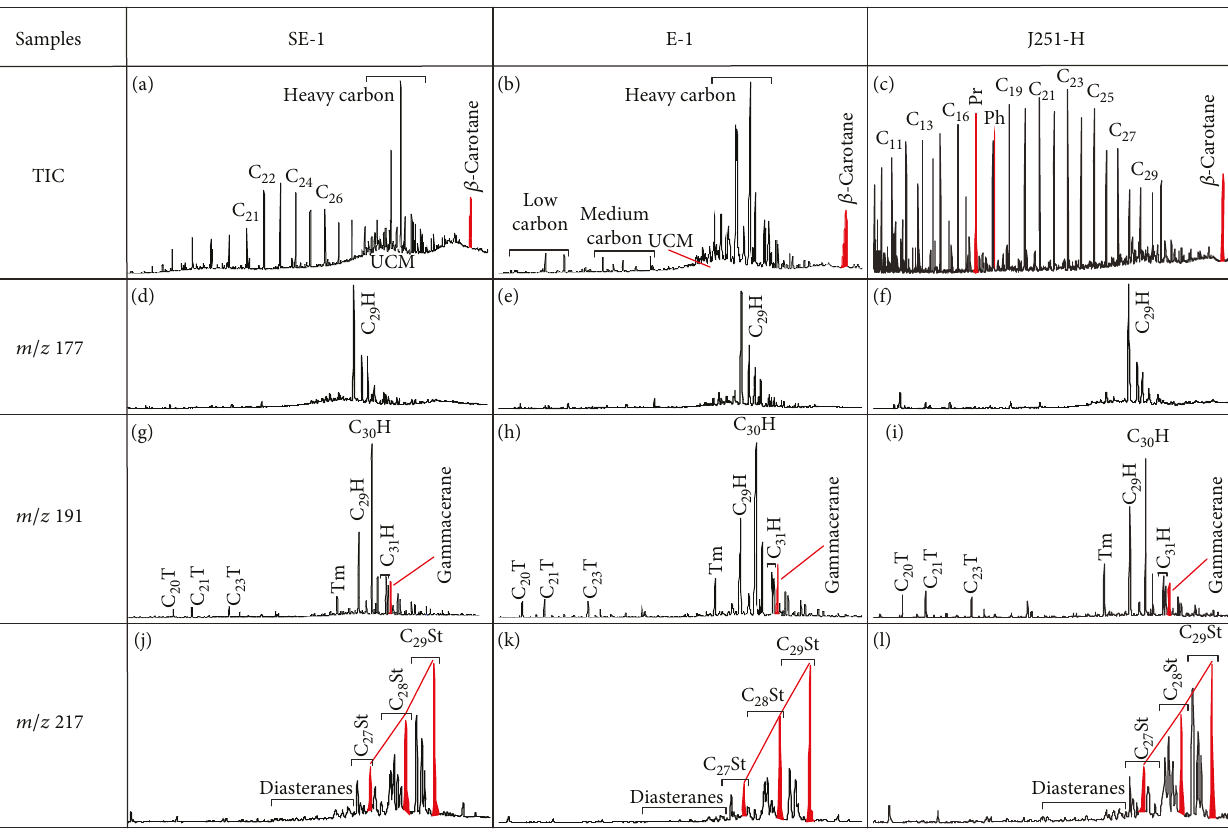
Figure 10: Selected molecular geochemical chromatograms of oil-seep and crude-oil samples from the eastern segment of the southern and eastern Junggar Basin. See Figure 4 for the